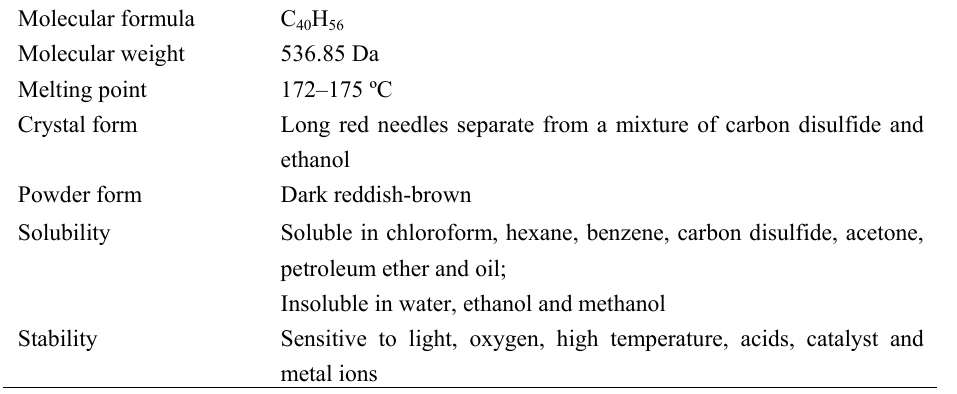
Table 1. Physical properties of